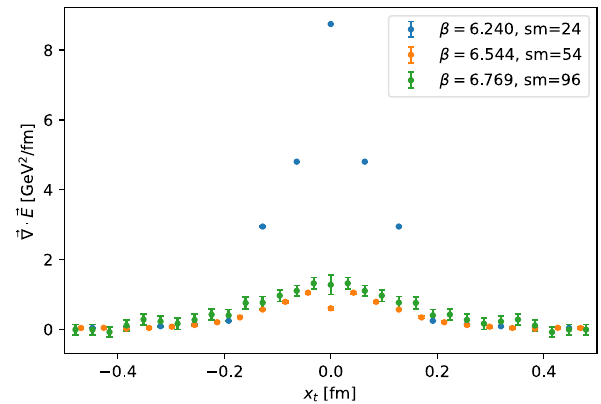
separated by d = 0 . 51 fm, corresponding to β = 6 . 769 after 96 smear- ing steps